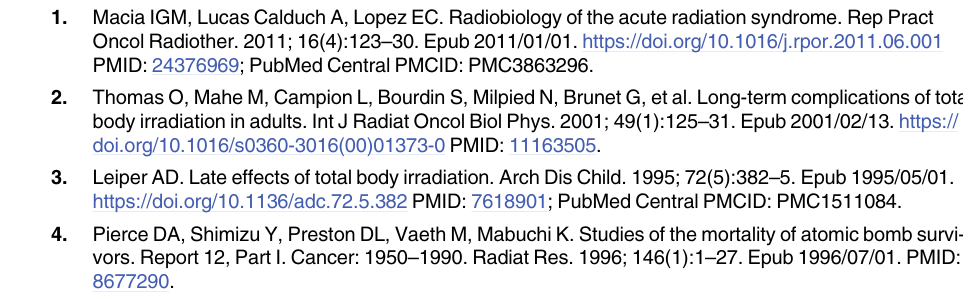
S1 Table. Complete blood count abnormalities observed at two and four weeks after irradi- ation. NT = no treatment; � p < 0.05; n = 10 animals per group. S1 Fig. Amino acid sequence of rat cTnT. The amino acid sequence of adult rat cTnT is fea- tured. Specific amino acid residues susceptible to carbonylation are